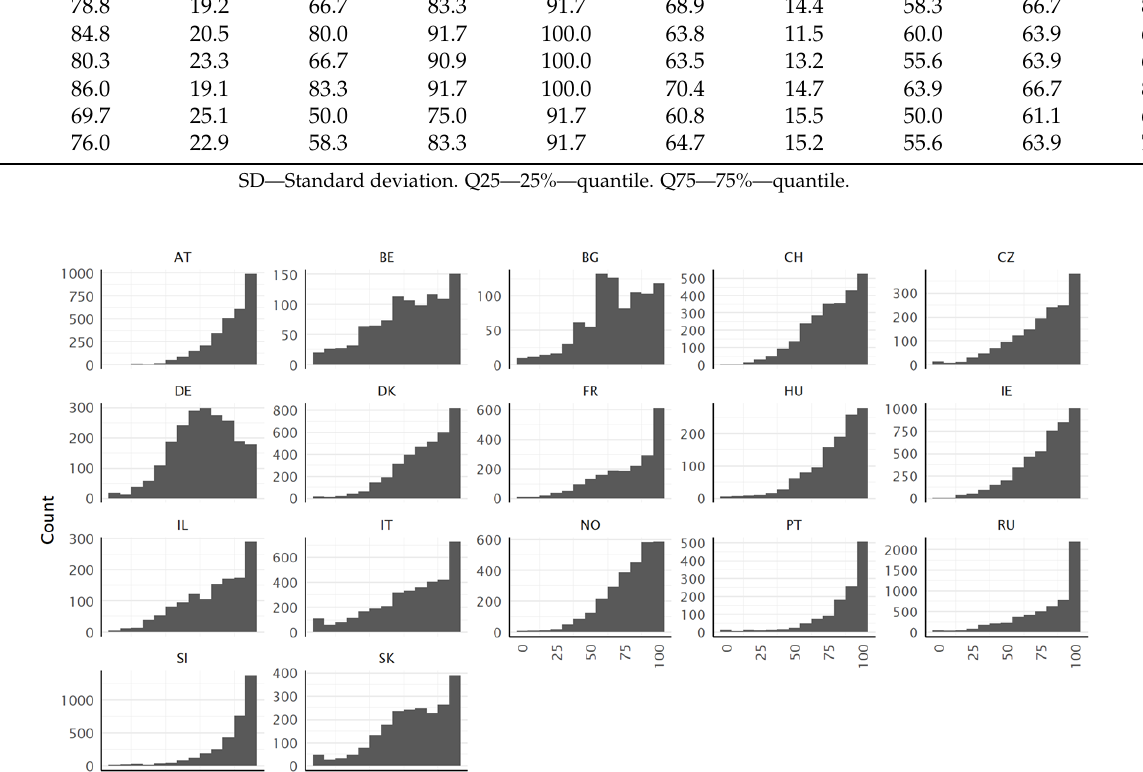
Figure 3. Histograms of the HLS 19 -Q12 scores (type P), for all countries. 3.3. Distribution of the Levels Across all participating countries, about 40% of the respondents have a “sufficient” level of HL and about 15% an “excellent” level (type D, Figure 4). On the other hand, about 33% have a “problematic” level of HL and 13% an “inadequate” level. The type P levels (Figure 5) give a less optimistic view on the general HL among the respondents of the HLS 19 surveys. While the pattern of the extreme categories resembles the type D levels (Figure 4), the relation of problematic to sufficient levels of HL differs